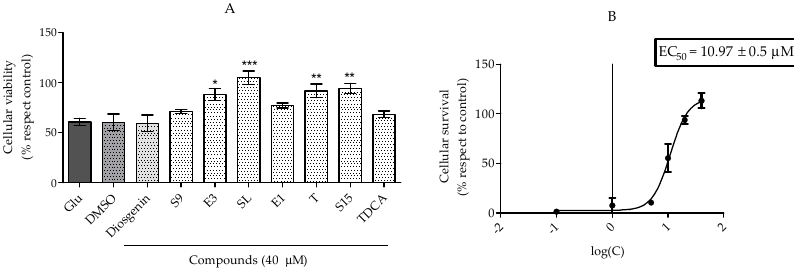
Figure 1. Anti-excitotoxic activity of compounds in glutamate-induced cell death. ( A ) PC12 cell cultures were exposed to an established excitotoxic concentration of glutamate (Glu) (20 mM), and some were also treated with each compound ( S9 and S15 semi-synthetic derivatives; E3, estriol; SL, solasodine; E1, estrone; T, testosterone; TDCA, taurodeoxycholic acid) or solvent control (DMSO). After 24 h of exposition to the damage and treatment, cellular viability was determined by the MTT assay; ( B ) Dose-response of Compound S15 in the same model of glutamate-induced excitotoxicity. Data are represented as the percent with respect to the untreated cells, representing the highest cell viability. * p < 0.05, ** p < 0.01 and *** p < 0.001, according to one-way ANOVA and Tukey’s post-hoc test.